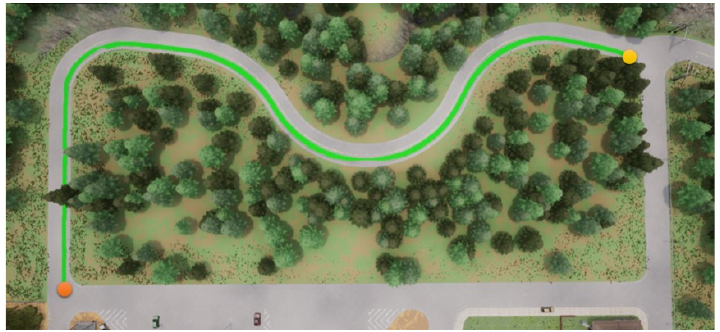
Figure 13. DDPG with a semantic segmentation camera for the first testing path.